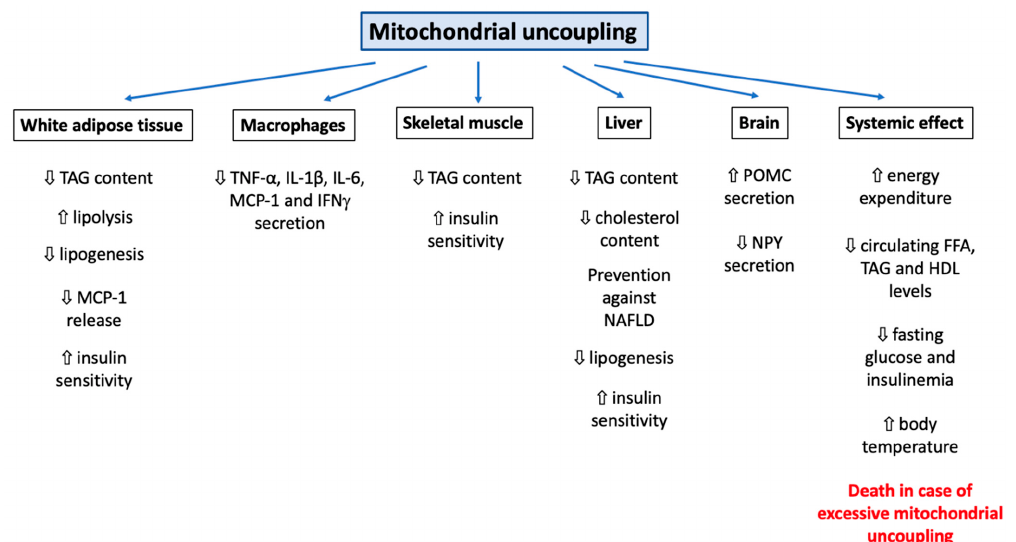
Figure 5. Systemic effect of mitochondrial uncouplers on different organs in the context of obesity and type 2 diabetes. Abbreviations: HDL (High Density Lipoprotein), IFN γ (Interferon γ ), IL (Interleukin), MCP-1 (Monocyte Chemoattractant Protein-1), NAFLD (Non-Alcoholic Fatty Liver Disease), NPY